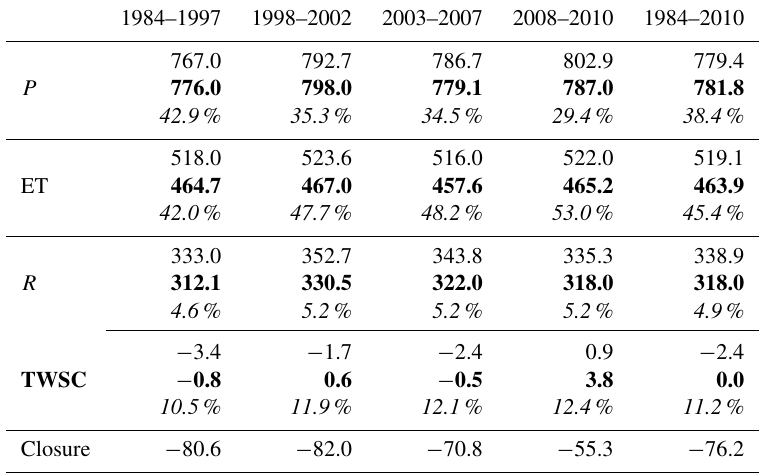
Table 3. Annual mean water budgets (mmyear − 1 ) over the globe (Greenland and Antarctica excluded) before (normal font) and after (in bold) water balance constraint, and their attributions (in italic) to non-closure error throughout